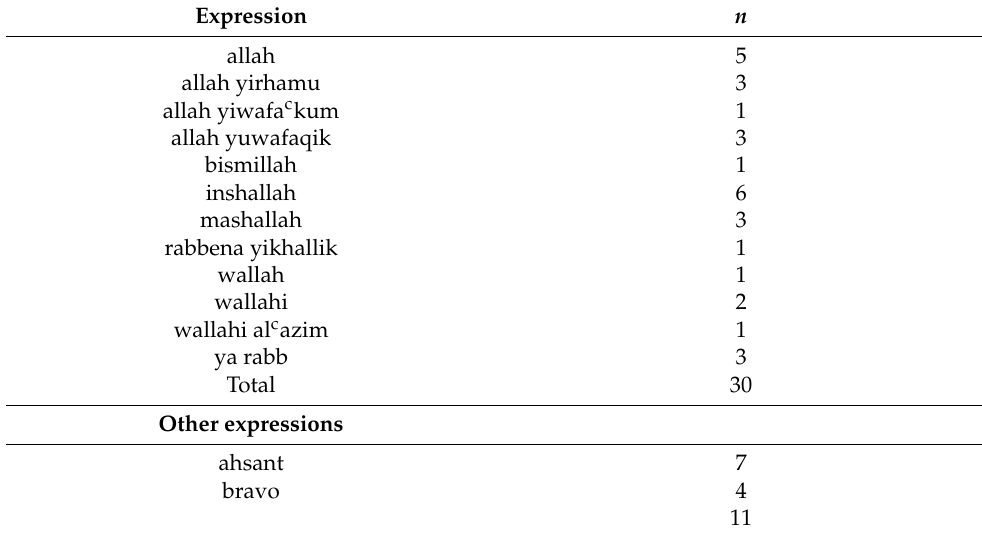
Table 6. Member of the jury Asi.